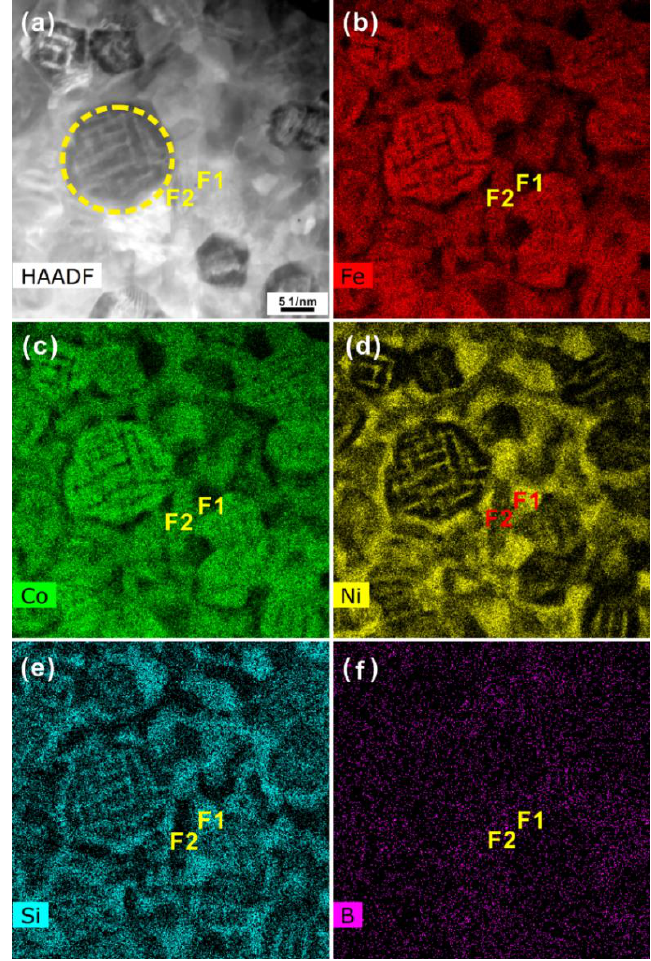
Figure 4. ( a ) HAADF image of the AR sample heated to 852 K as well as its chemical distributions of elements ( b ) Fe, ( c ) Co, ( d ) Ni, ( e ) Si, and ( f ) B.